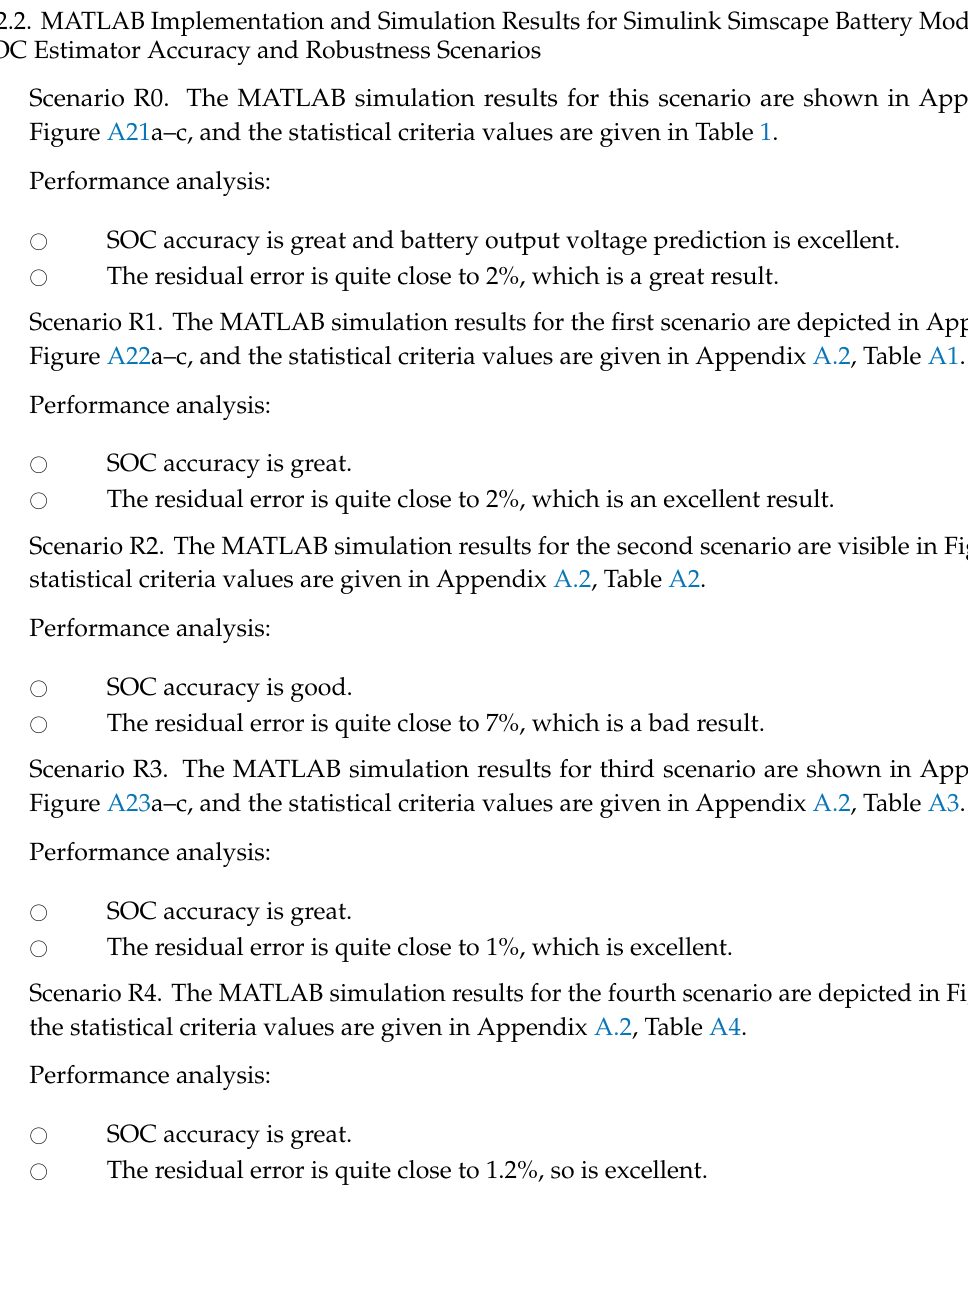
Figure 7. Robustness to simultaneous changes, SOCini = 0.2, and output temperature profile changes; ( a ) AUKF SOC value versus battery model true value; ( b ) SOC residual.